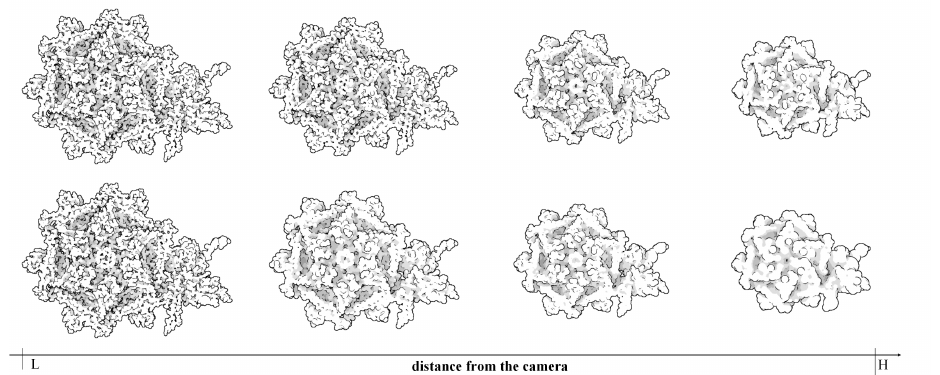
Figure 5. Comparison of zooming out towards the molecule (ID:1OHG) performed using the bounding ellipsoid ( top ) and the bounding sphere ( bottom